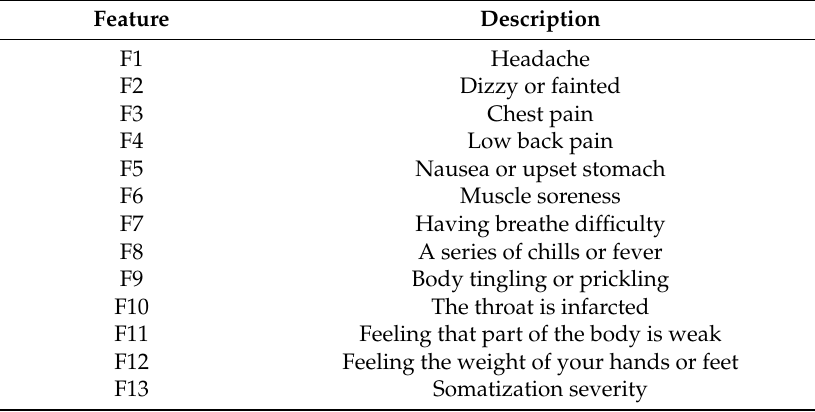
Table 1. Description of the somatization disorder